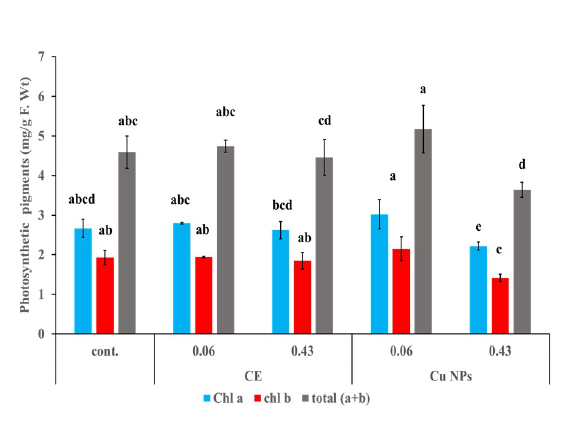
Fig 9. Chlorophyll a, b and total chlorophyll contents upon exposure to CE and Cu NPs.